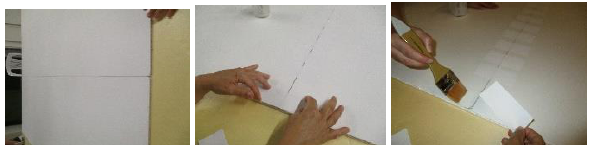
Figure 18 - Three moments of the panels gluing process.